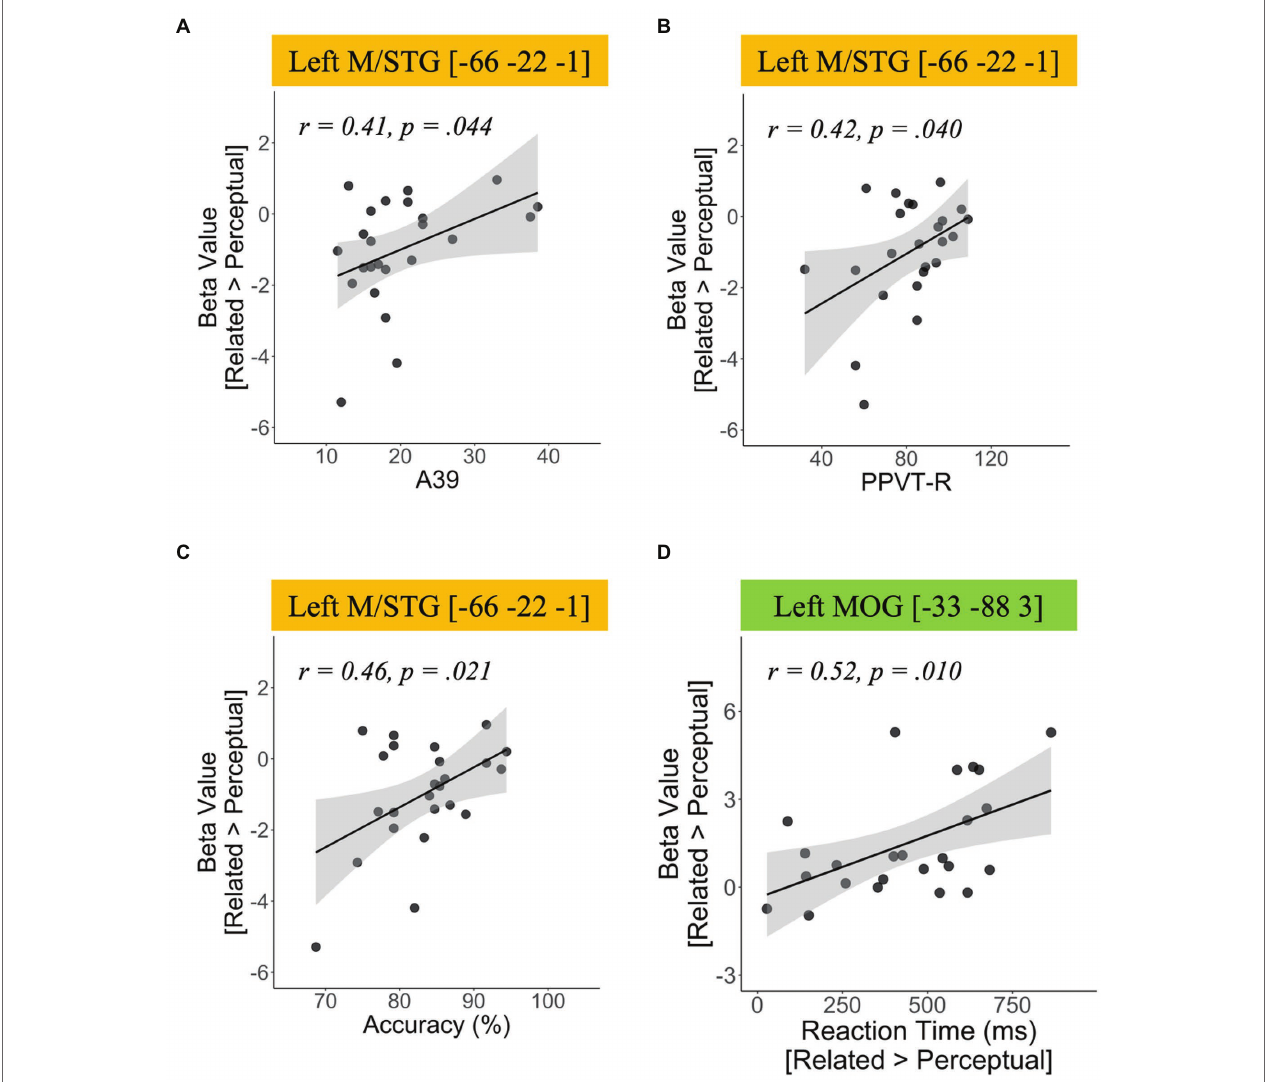
FIGURE 2 | Correlation results of brain activation for the contrast of (semantic-related condition vs. perceptual control condition) in the L2 group. (A) Correlation between activation in the left middle temporal gyrus/superior temporal gyrus (M/STG) and Peabody Picture Vocabulary Test-Revised scores, (B) correlation between activation in the left M/STG and A39 scores, (C) correlation between activation in the left M/STG and accuracy, and (D) correlation between activation in the left middle occipital gyrus and reaction